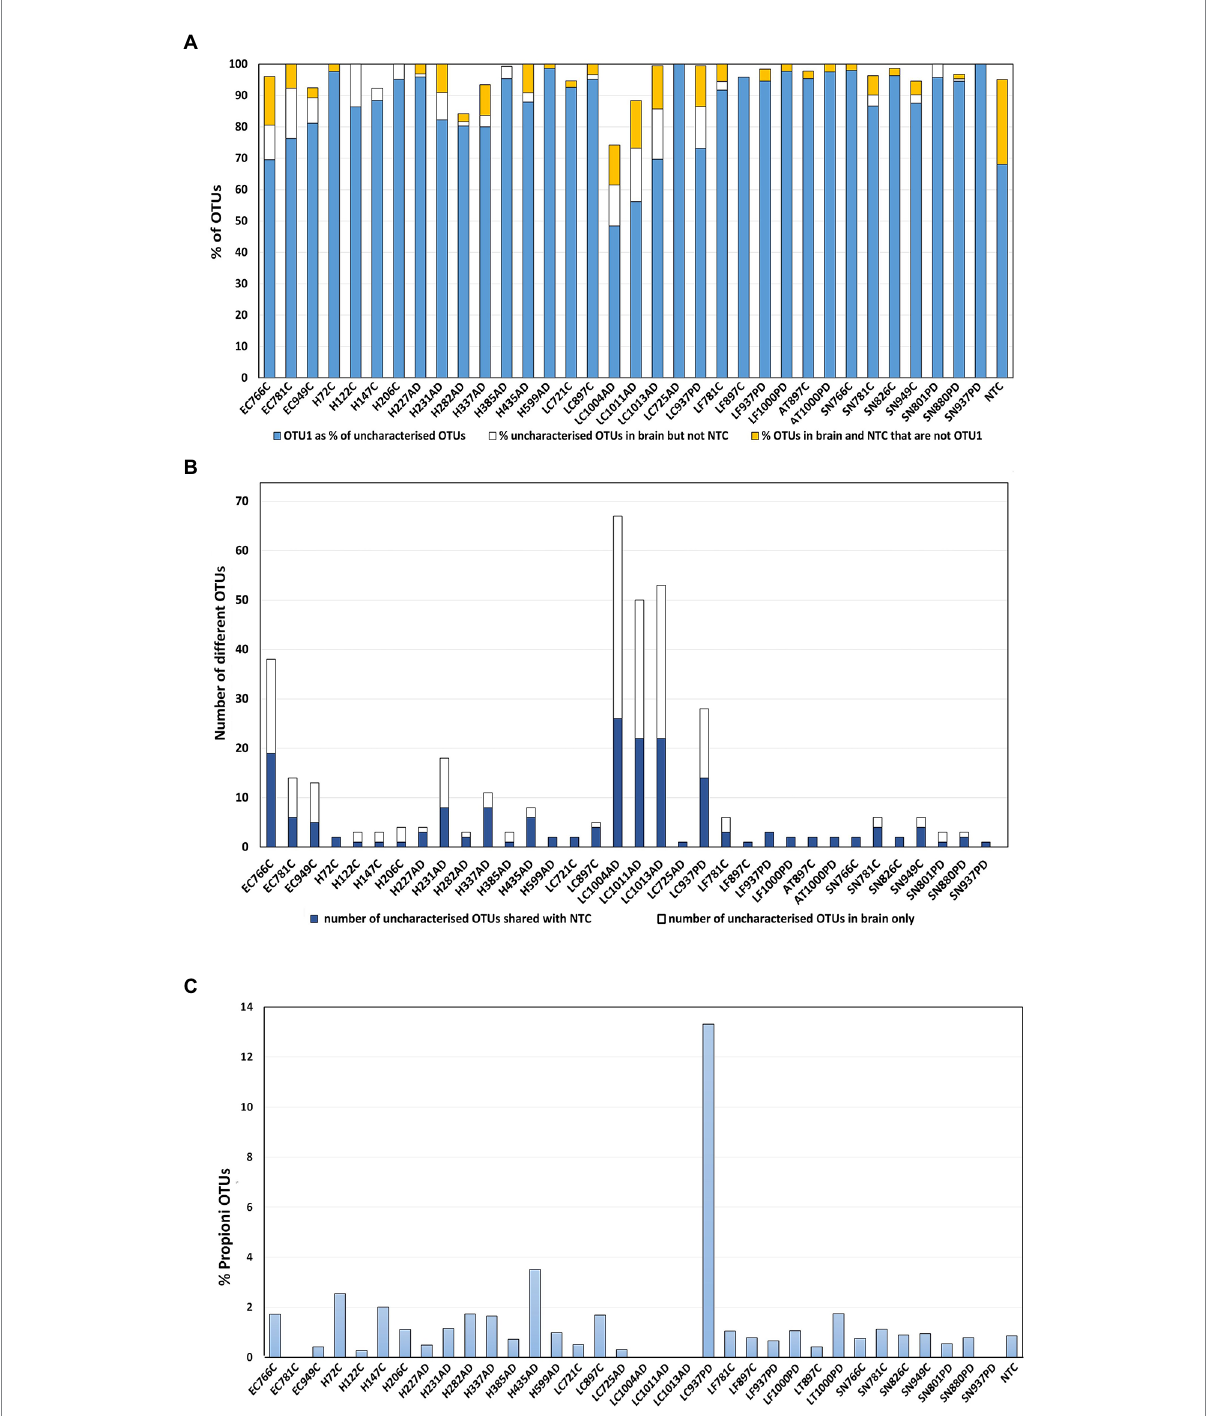
FIGURE 4 Uncharacterized OTUs. (A) OTU1 as a percentage of the total uncharacterised OTUs per sample shown in blue, this was defined by MED as ‘Kingdom’ (k_bacteria;p), attributed by BlastN analysis as Cutibacterium acnes . In gold: the percentage of uncharacterised OTUs per sample that are not OTU1 and are in both brain and NTC. In white: the percentage of uncharacterised OTUs per sample that are not OTU1 that are in brain only. (B) Numbers of different uncharacterised Cutibacterium OTUs per sample only in brain (blue); number in brain and also in NTC (white) (C) Relative abundance of f_ Propionibacteriacea overall in each sample. 12 OTUs were defined to family (f) Propionibacteriaceae; BlastN analysis showed close correspondence of these to Cutibacterium granulosum